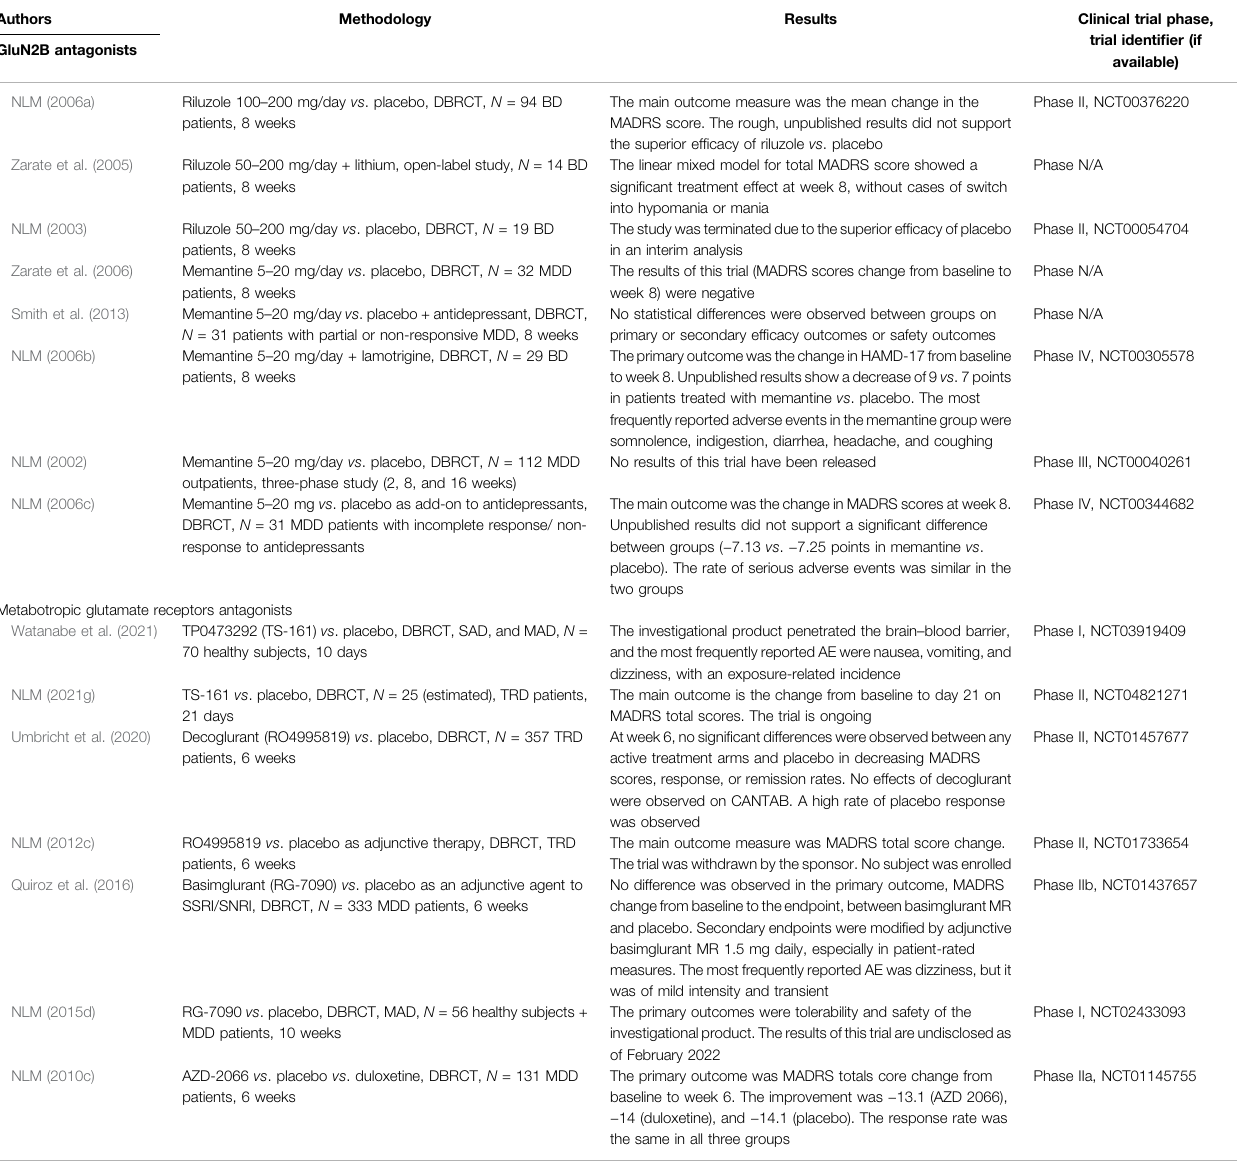
TABLE 1 | ( Continued ) Glutamatergic agents with antidepressant properties in the pipeline. Authors Methodology Results